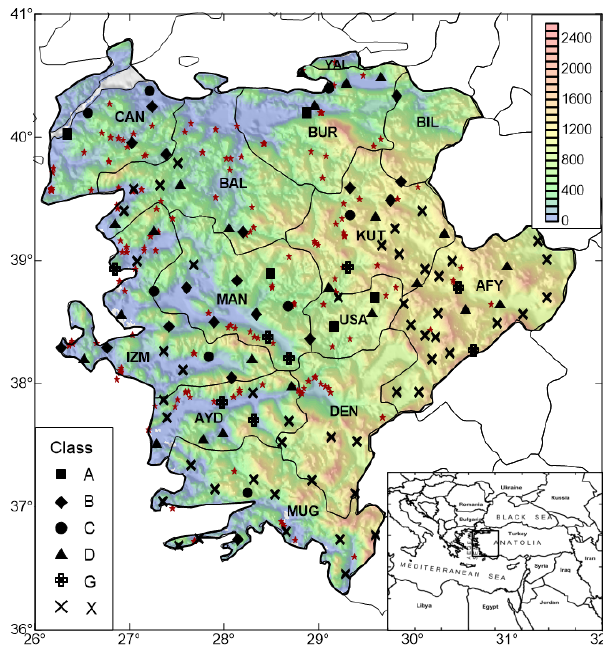
Figure 1. Data locations with the corresponding quality classes. See the text for details of the class definitions. Red star symbols show locations of hot springs. Elevations are in meters. Acronyms for administrative provinces are as follows: CAN: Çanakkale; BAL: Balıkesir; BUR: Bursa; BIL: Bilecik; KUT: Kütahya; MAN: Man- isa; USA: U¸sak; AFY: Afyon; IZM: Izmir; DEN: Denizli; AYD: Aydın; MUG: